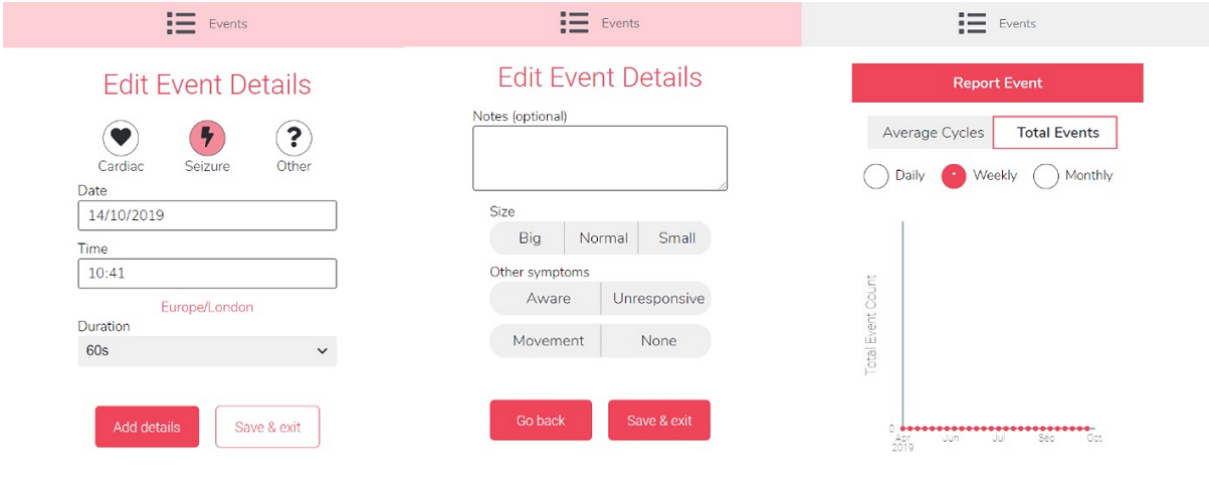
Figure 3. Multiple screens of the Seer app’s events